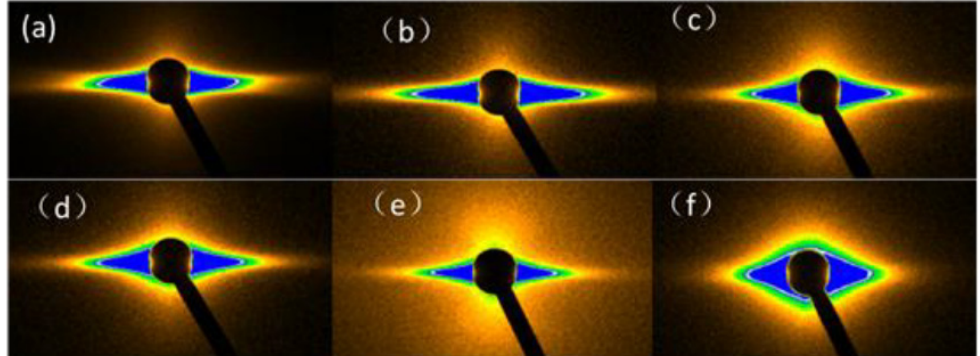
Figure 9. Small-angle X-ray scattering (SAXS) patterns for Kevlar49 fibers treated in different conditions ( a )—as received, ( b – f )—treated in scCO 2 with toluene 2,4-diisocyanate (TDI) under various tensions 0, 0.2, 0.4, 0.6, 0.8 cN/dtex.